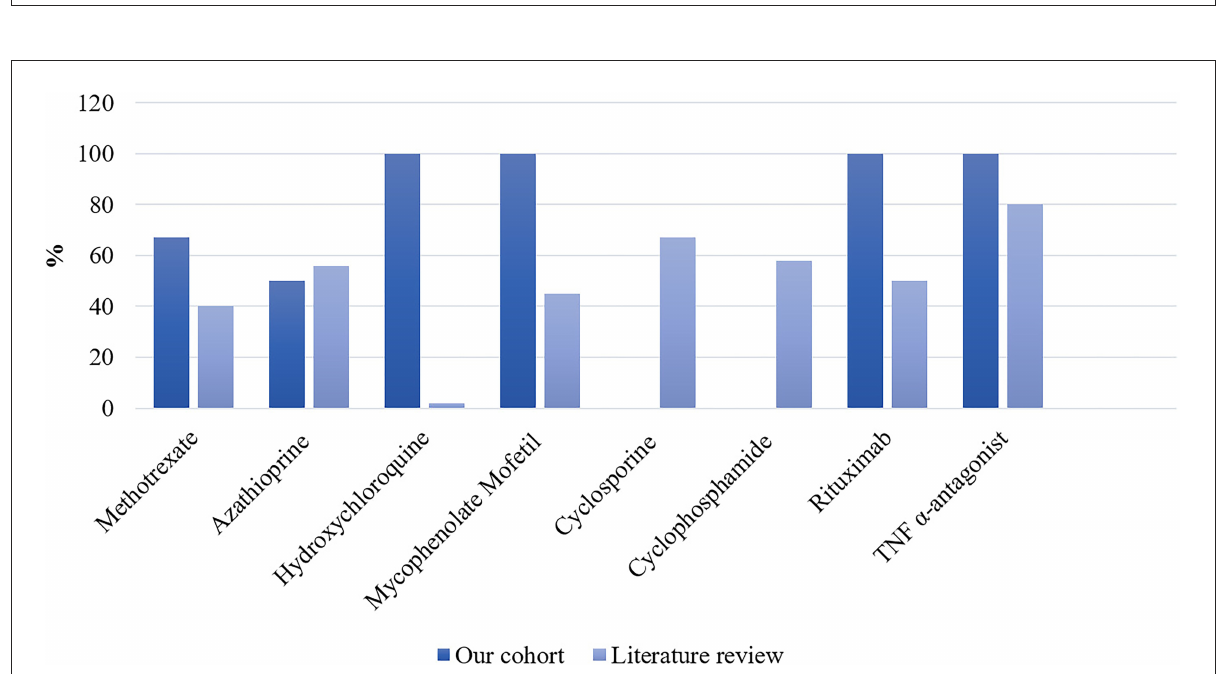
FIGURE5 Proportion of favorable outcomes in patients from our cohort ( n = 22) and the literature expressed as percentages. In the literature: n/N = 56/140 for methotrexate; n/N = 31/56 for azathioprine; n/N = 1/60 for hydroxychloroquine; n/N = 27/60 for mycophenolate mofetil; n/N = 10/15 for cyclosporine; n/N = 19/33 for cyclophosphamide; n/N = 2/4 for rituximab; and n/N = 280/352 for TNF- α